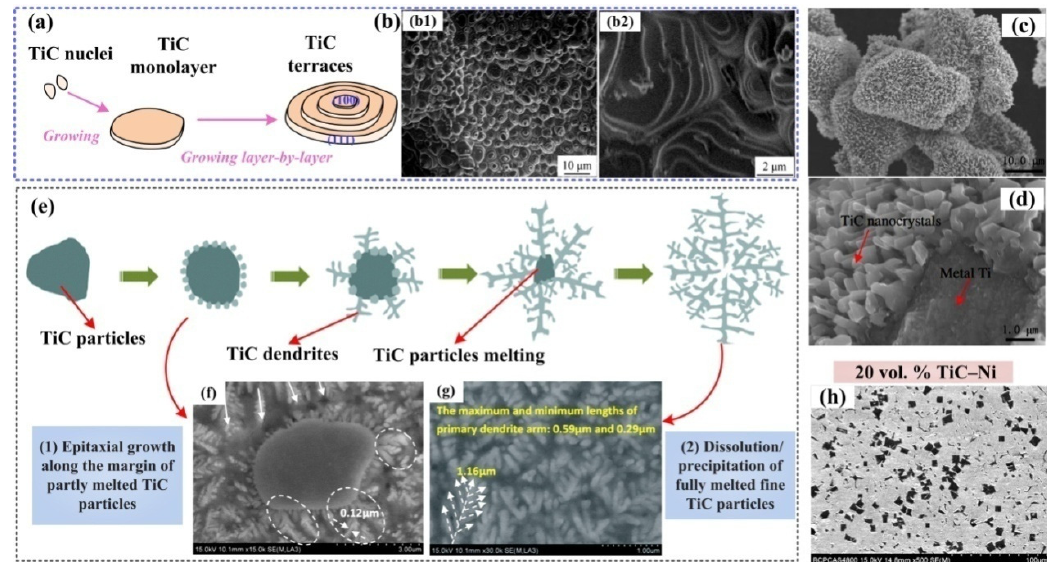
Figure 15. ( a ) Scheme of the growth process of TiC terraces in Fe-Ti-C system. ( b ) The morphology of TiC terraces synthesized in the Fe-Ti-C system. With permission from Reference [18], copyright (2011) Elsevier; ( c , d ) The TiC nanocrystal clusters that grow on the surface of Ti particles, with permission from Reference [120], copyright (2015) Elsevier; ( e ) Based on the TiC particles complete melting mechanism, the integrated dendrite development schematic diagram. ( f , g ) The actual TiC particles melting and dendrite development. With permission from Reference [17], copyright (2017) Royal Society of Chemistry; ( h ) The microstructure of 20 vol.%TiC / Ni composites. The large cubic TiC is the primary phase, while the fine fibrous shape is the eutectic phase. With permission from Reference [122], copyright (2010)